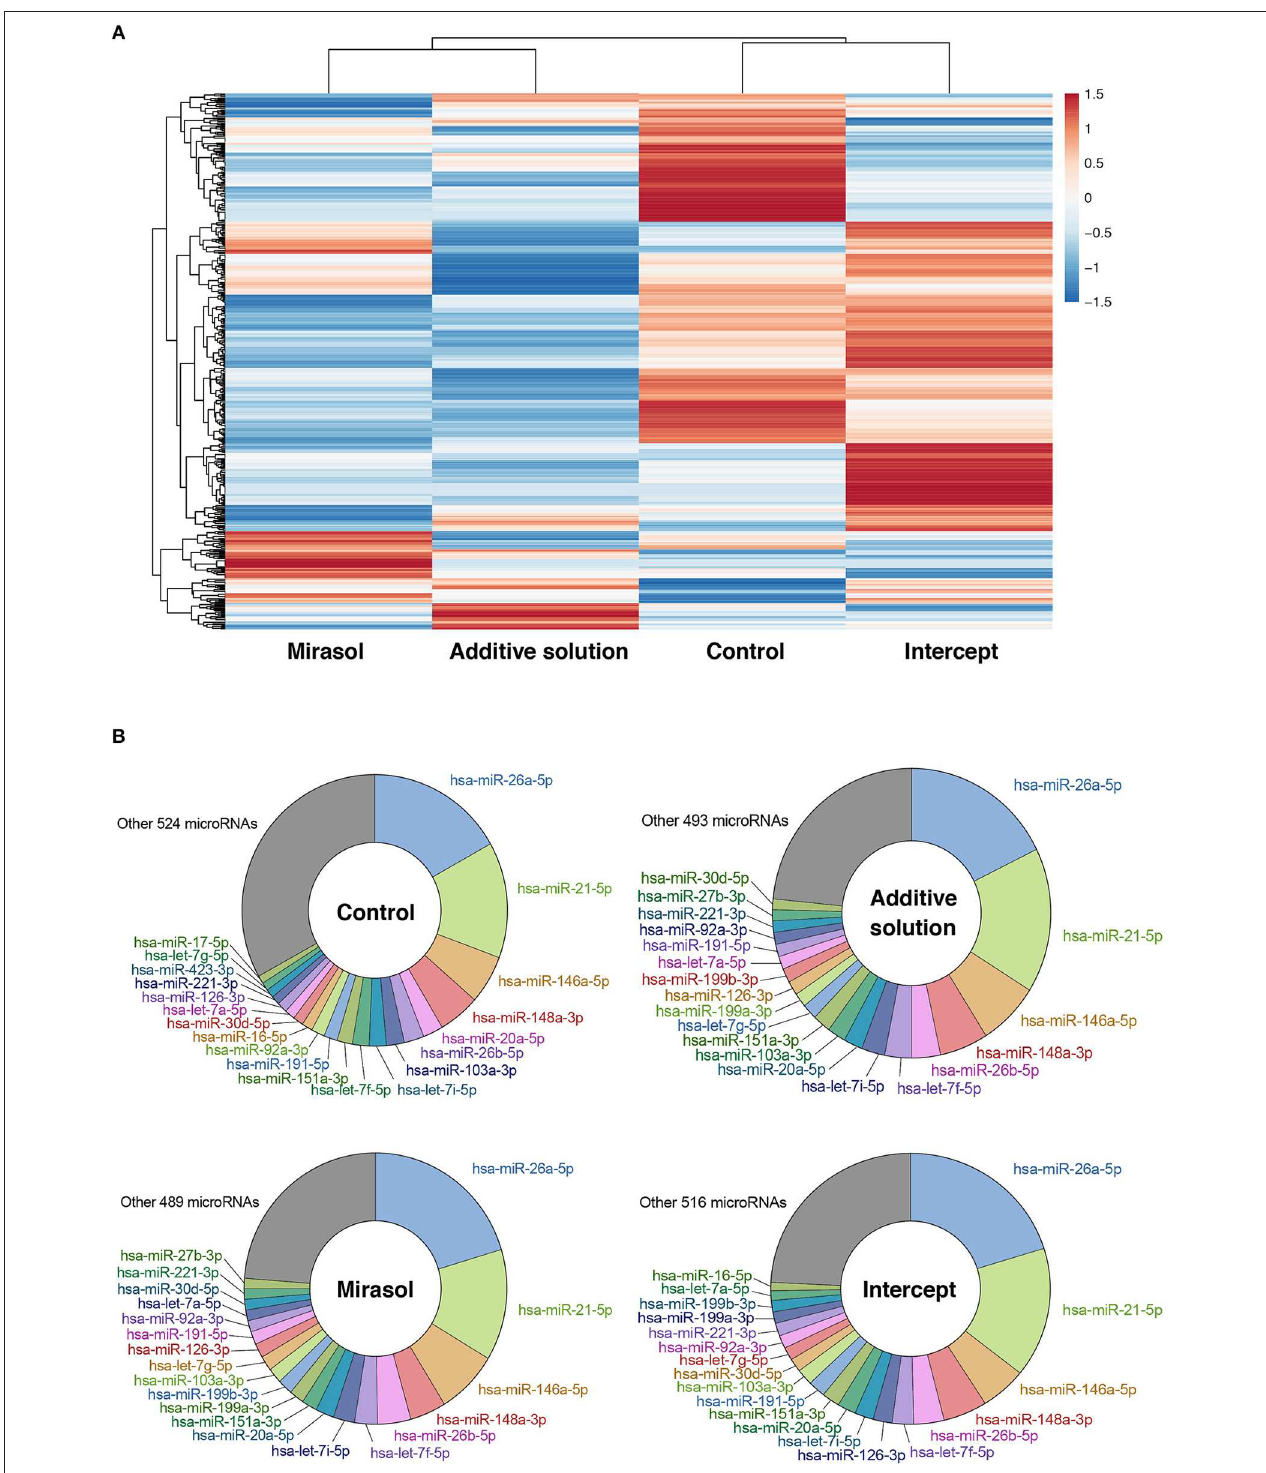
FIGURE 1 | MicroRNA profile of PRT-treated human platelets. Clinical PCs were either left untreated in donor plasma (Control group) or treated with PRT agents Mirasol or Intercept, or with the Additive solution, used as the vehicle control for Intercept. Platelets were isolated from the clinical PCs, and total RNA was extracted and pooled from six donors per group prior to small RNA-Seq analysis. (A) Heatmap representation of the platelet microRNA profiles with clustering analysis, where fold changes vs. control PCs are indicated in graded color intensity. (B) Circular diagram representing the 20 most abundant microRNAs in each pooled sample, along with other microRNAs and their relative proportion. PCs, platelet concentrates; PRT, pathogen reduction technologies.